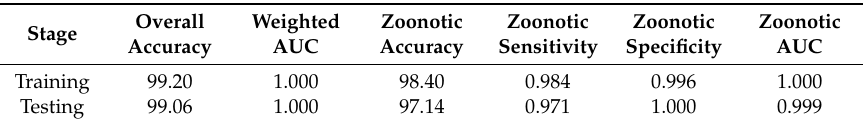
Table 1. Performance evaluation of random forest zoonotic strain prediction model. AUC: area under the receiver operating characteristic